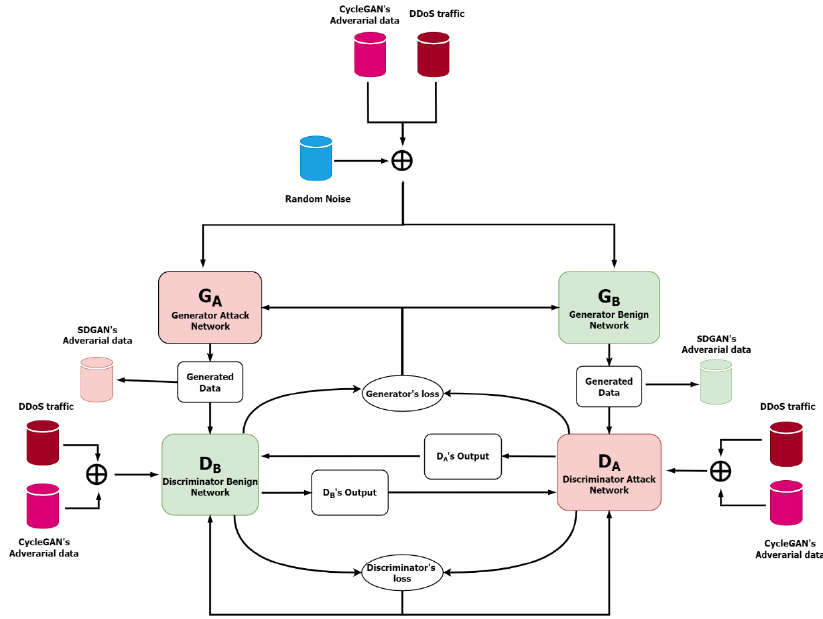
Figure 5. The architecture of